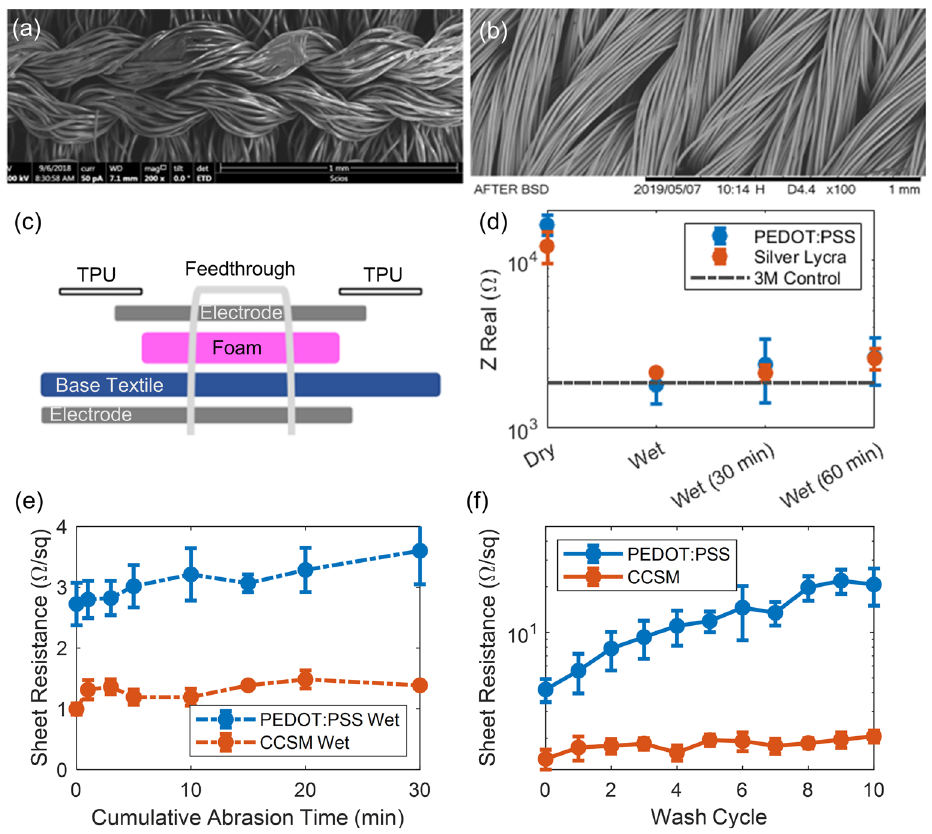
Figure 5. Characterization of PEDOT:PSS and CCSM electrodes. SEM image of ( a ) polyester impregnated with PEDOT:PSS and ( b ) CCSM. ( c ) Schematic of electrode stack up. ( d ) Impedance measurements of PEDOT:PSS and CCSM when dry and wet at 1 kHz (n = 2 coupons). Sheet resistance of PEDOT:PSS and CCSM versus ( e ) cumulative abrasion time (n = 3 coupons) and ( f ) laundering cycles (n = 5